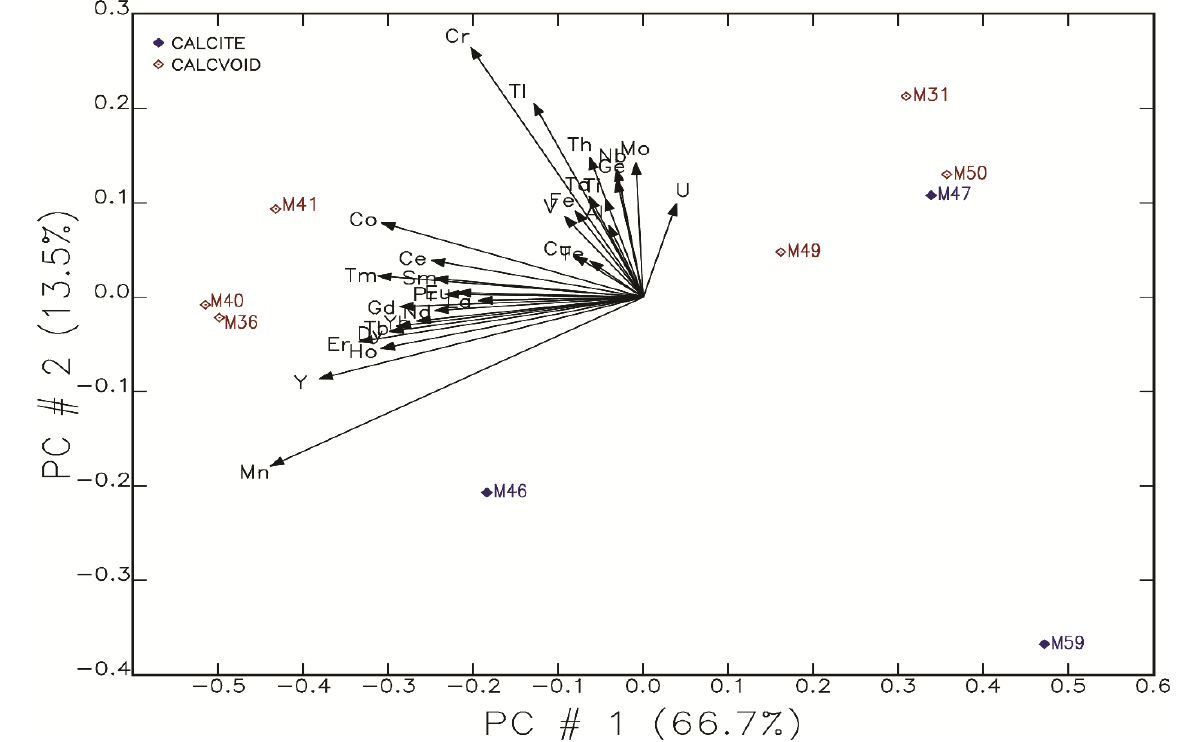
Figure 12. Scatterplot of the first two Principal Components, accounting for 70.2% of the total variance within petrographic fabric C-1, demonstrating the chemical heterogeneity caused by post-depositional alteration.